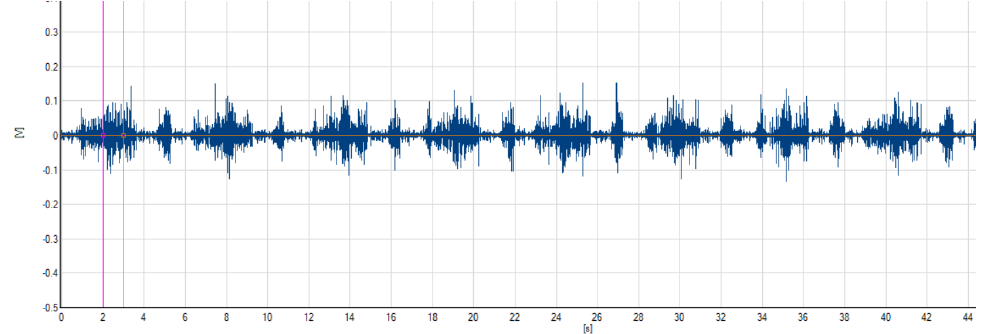
Figure 3. Filtered EMG signal.